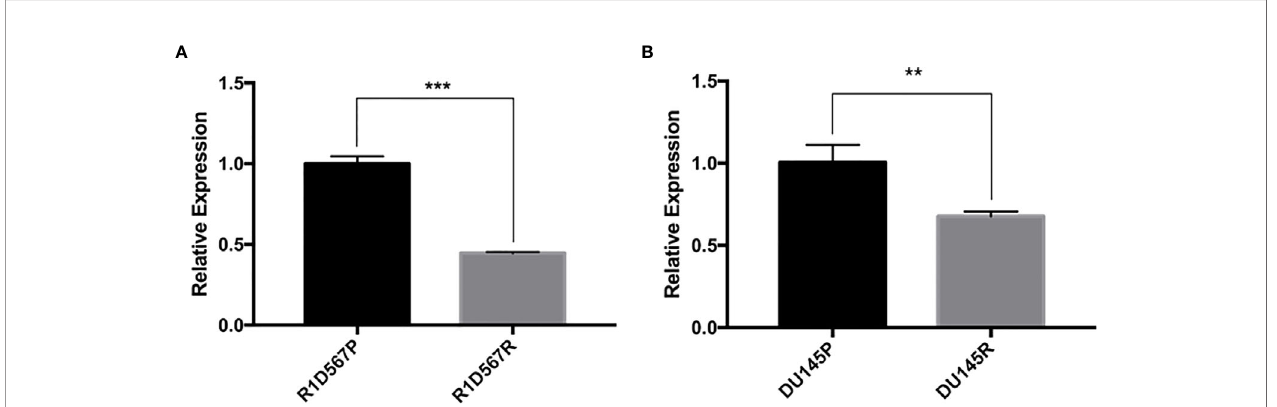
FIGURE 2 | Docetaxel resistant PCa cell lines exhibit lower GAS5 expression when compared to parent docetaxel sensitive PCa cell lines. The expression was measured using real-time RT-PCR and was normalized to GAPDH expression. (A) Comparison of relative GAS5 expression levels in R1D567 parental line (R1D567P, black bar) and docetaxel resistant line (R1D567R, grey bar). (B) Comparison of relative GAS5 expression levels in DU145 parental line (DU145P, black bar) and docetaxel resistant line (DU145R, grey bar). ** P < 0.01, *** P <